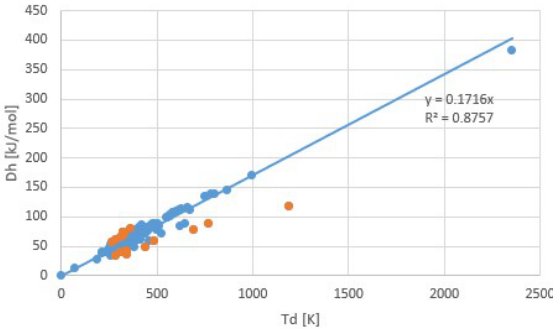
Figure 10. Trouton’s rule for salt hydrates. Orange points are entries with highest and lowest transition entropy. The regression coefficient r 2 = 0.8757 is considerably smaller than for chloride ammoniates.